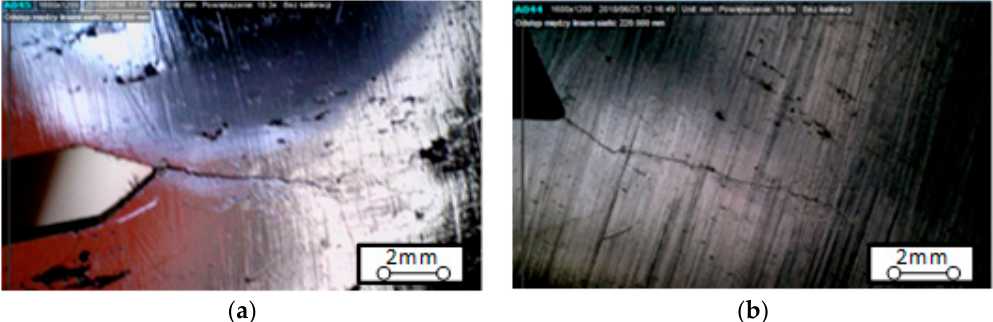
Figure 17. Mixed mode fatigue crack path in the CTS specimen ( a ) for R = 0.5; ( b ) for R = 0.05.